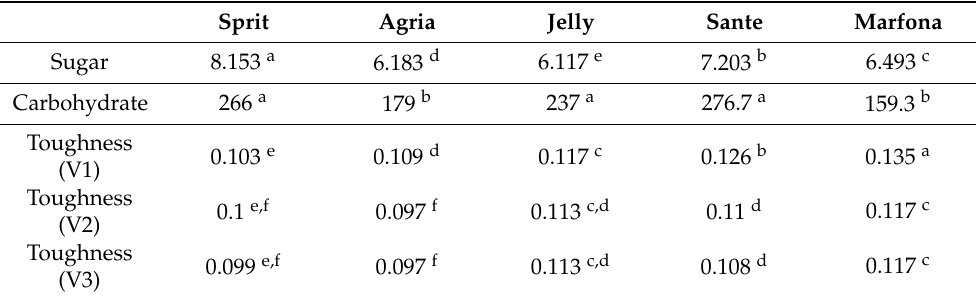
Table 2. Results of Duncan mean comparison testing for sugar content, carbohydrate content, and toughness of potato cultivars ( α = 0.01). Sprit